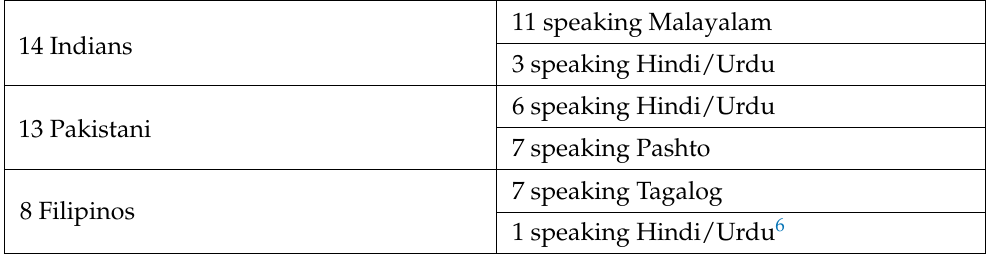
Table A1. Details of the nationalities of the workers taking part in this